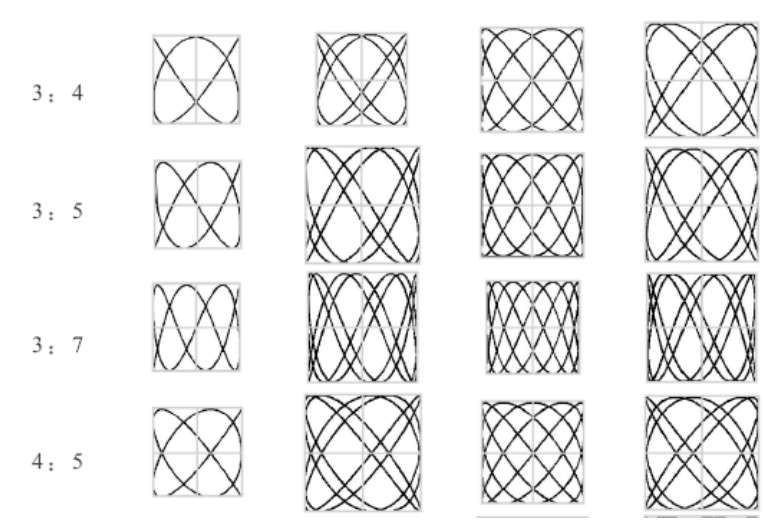
Figure 6. Lissajous verification table.